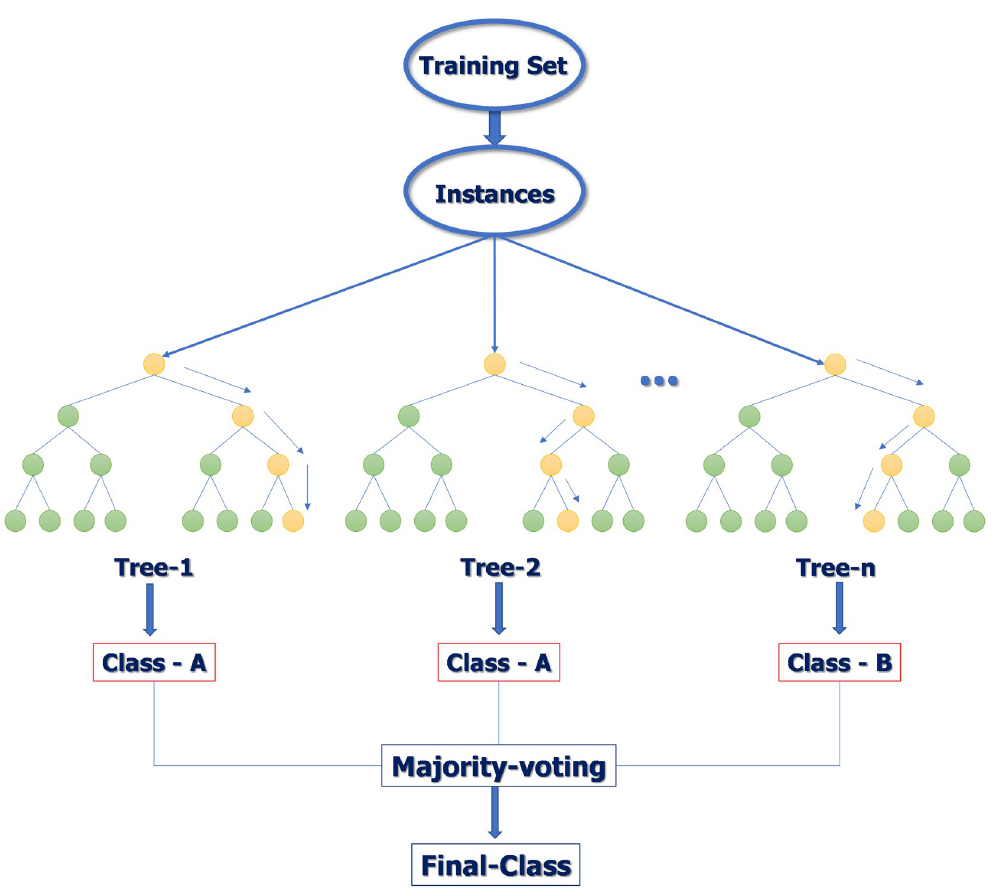
Fig 3. Flow chart of classification using Random Forest algorithm (Source: https://www.section.io/engineering- education/introduction-to-random-forest-in-machine-learning/).